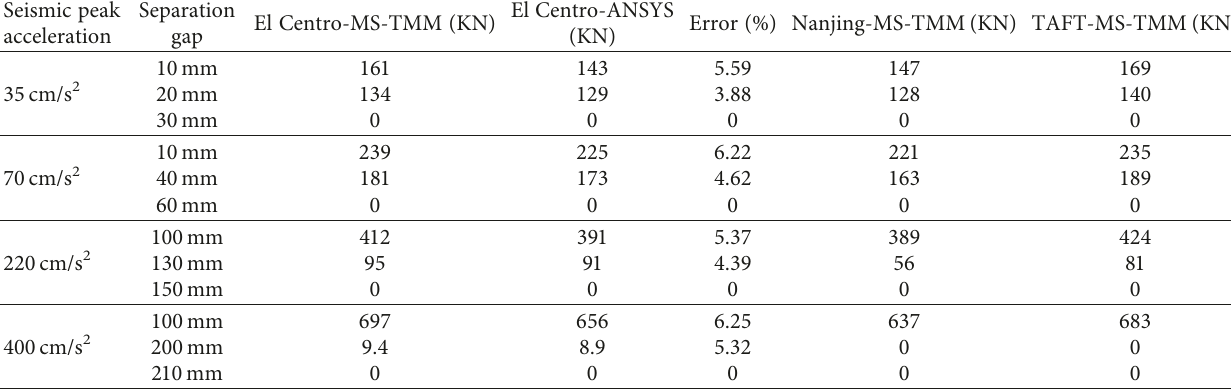
a -J 1 , a under seismic wave. 2 , 35 15